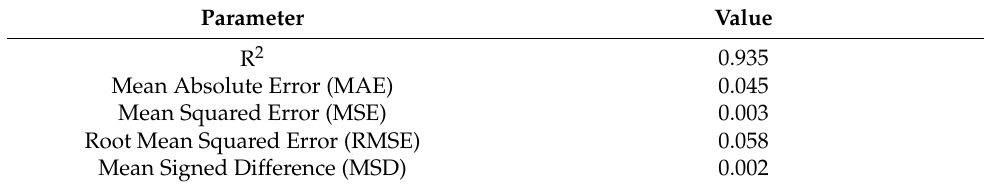
Figure A3. KNIME workflow of implementing the ANN-MLP algorithm in predicting energy power. Table A1. Parameters of ANN-MLP